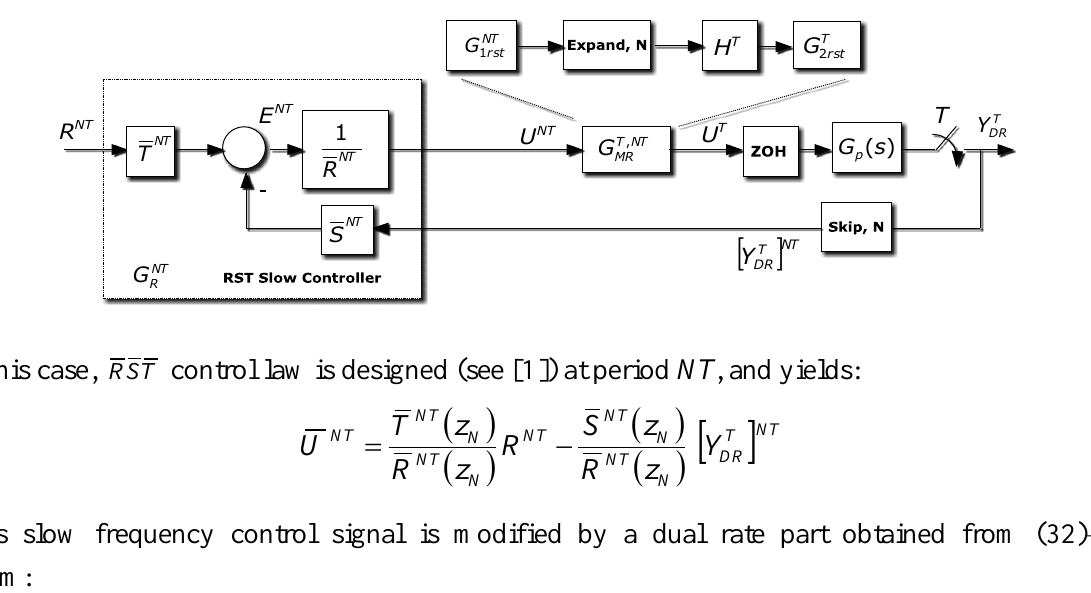
Figure 5. Block diagram for the control system: multi-rate controller including an RST